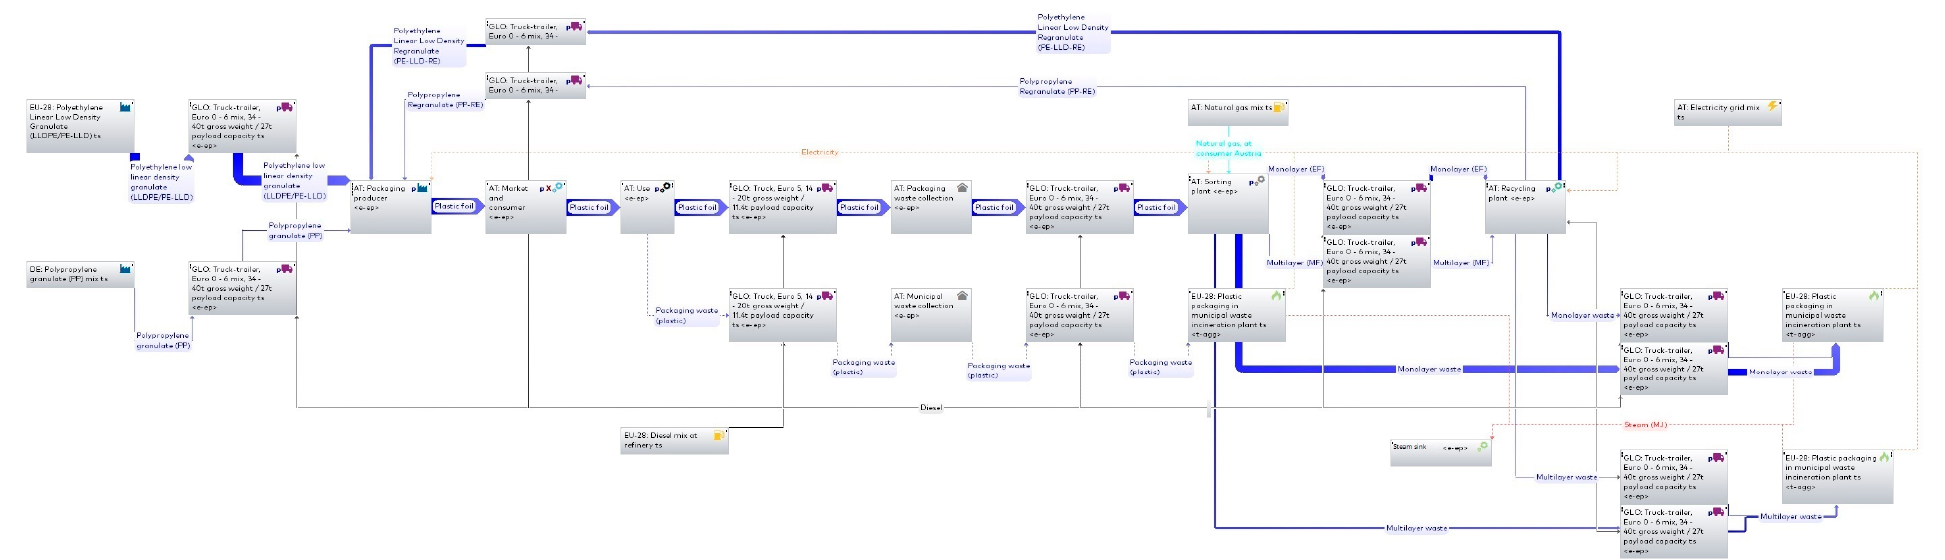
Figure A1. Balanced Life Cycle using GaBi